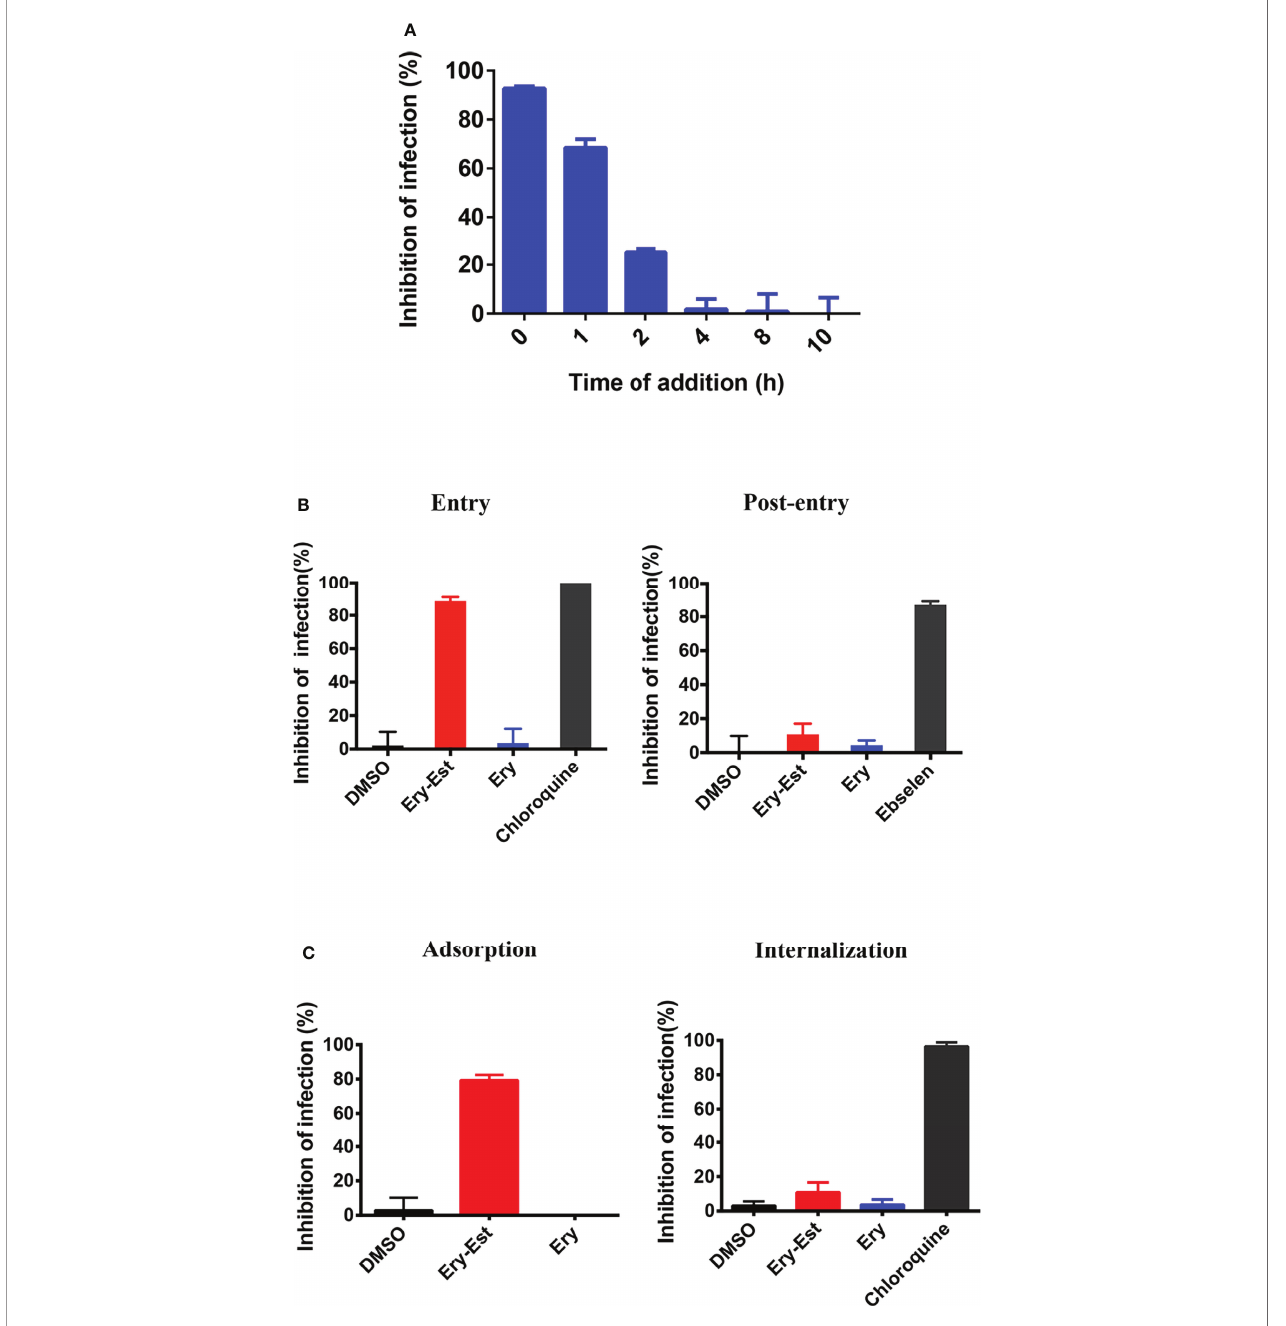
FIGURE 3 | Ery-Est inhibited HCoV-OC43 infection at the early stage. (A) Time-of-addition assay showed inhibitory activity of Ery-Est within 2 h after HCoV-OC43 infection. (B) Ery-Est suppressed virus entry but barely affected the post-entry stage. (C) Ery-Est disturbed the step of attachment but had not impact on viral internalization. Each experiment was performed in triplicate, and the data were presented as means ±